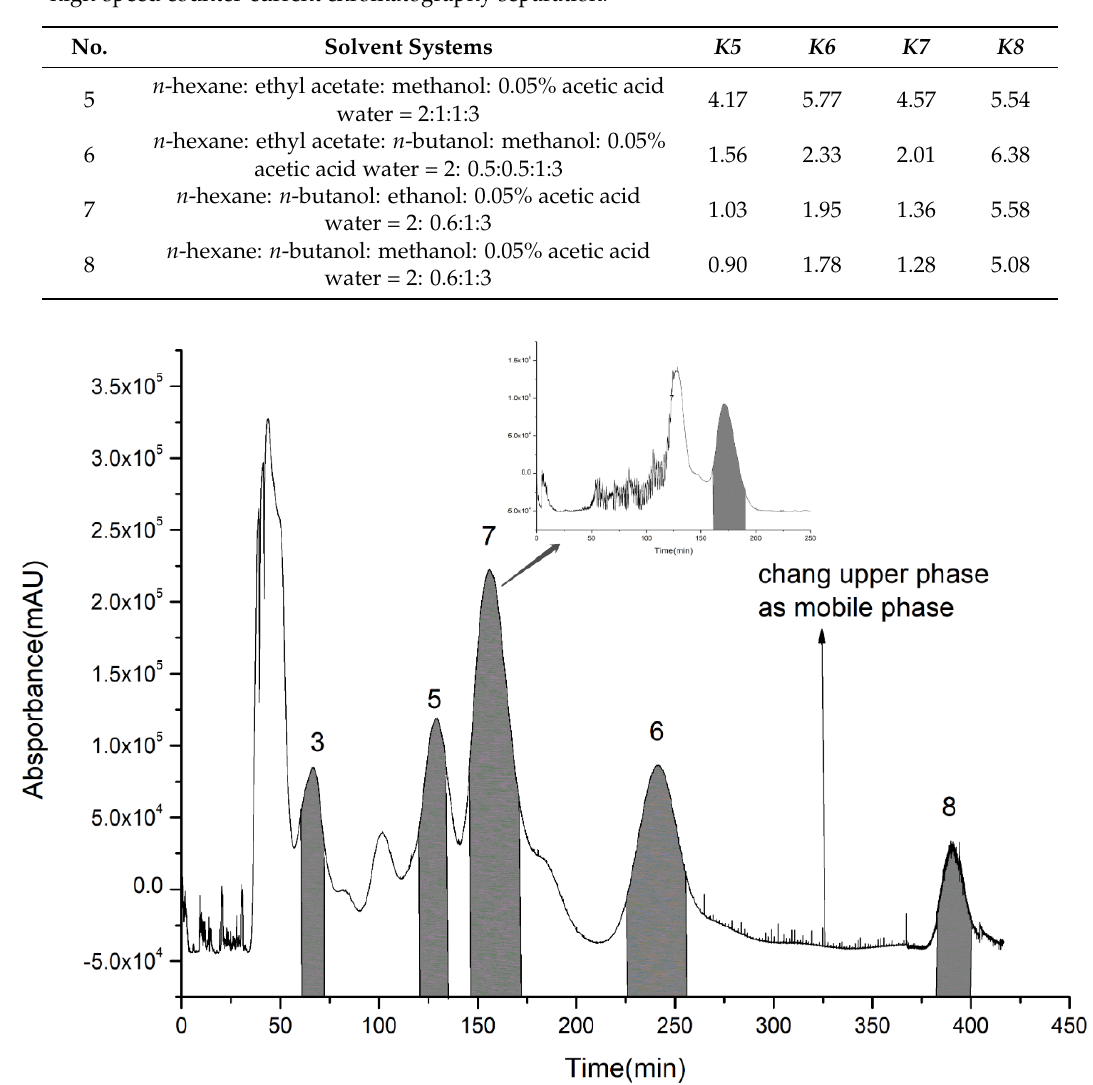
Figure 5. Extract of 95% ethanol eluent via high-speed counter-current chromatography.